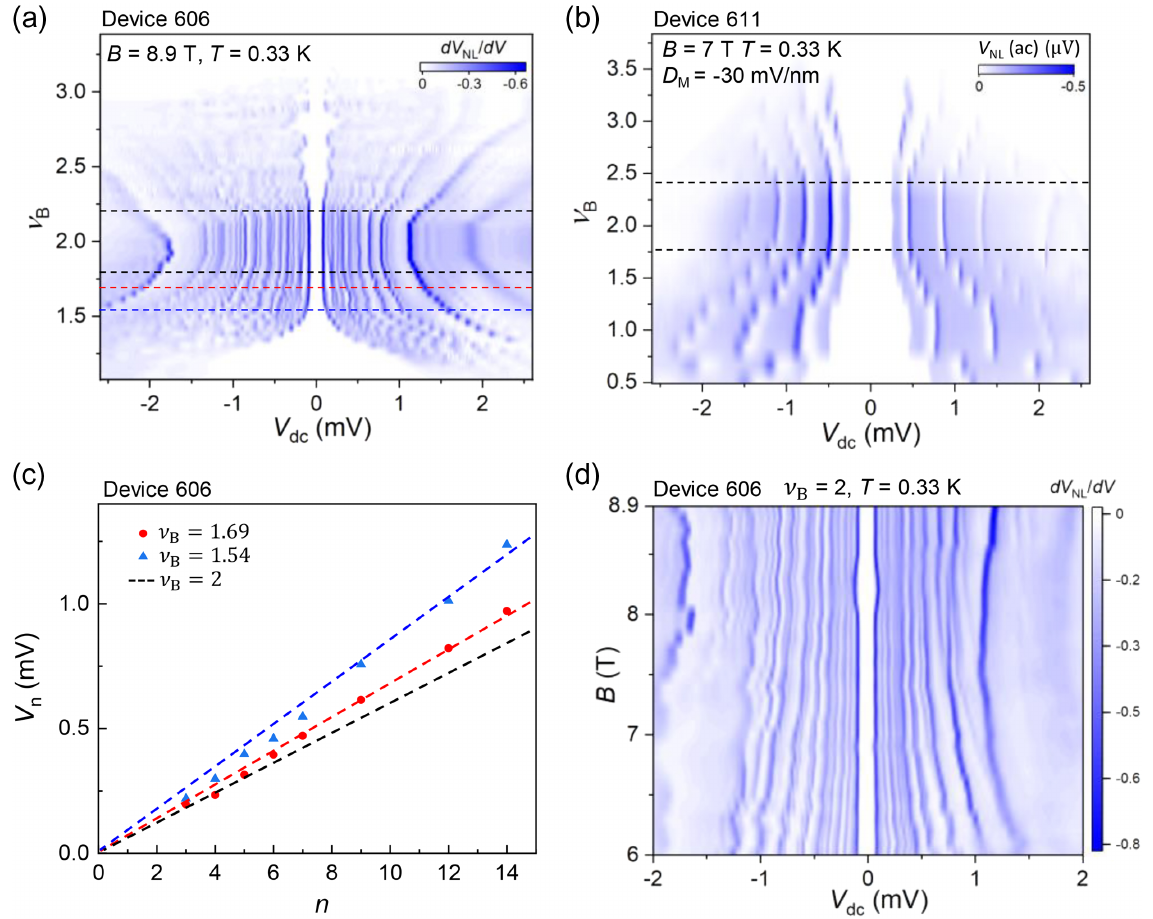
=dV on the bulk filling factor ν FIG. 16. The dependence of dV and the external magnetic field with a constant gating condition of NL B =dV as a function of ν the CAF phase. (a) and (b) show the evolution of dV in device 606 and 611, respectively. The nonlocal signal NL B ¼ ð 2 (cid:3) 0 . 2 – 0 . 3 Þ (regions within the black dashed lines in both graphs). is insensitive to the change of ν in the filling factor range of ν B B Further deviation of ν leads to amplitude reduction and simultaneous blueshift of resonant mode energies. The details are sample B dependent. (c) characterizes the shift of the mode energy at two different filling factors as indicated by the blue and red dashed lines in (a). Larger shifts are observed for higher harmonics. Δ V is roughly linear in n , as the dashed lines show. (d) shows the evolution of n ¼ 2 . Blueshift of resonant modes occurs at B < 7 . 5 T. This trend is at odds with the dV =dV as a function of B while keeping ν NL B ¼ 2 theoretical expectation of a decreasing SW velocity with decreasing B , as discussed in the main text. We suspect that a weakened ν B at lower field reduces the spin polarization of the bulk, and the blueshift of the modes shares the same origin as the ν dependence shown B in (a) and (b). A microscopic understanding of the nonequilibrium emission and detection process including dissipation channels can help understand these